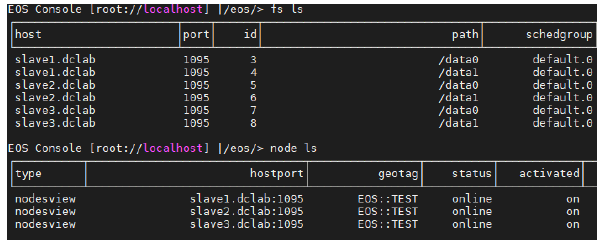
Figure 7. EOS console.